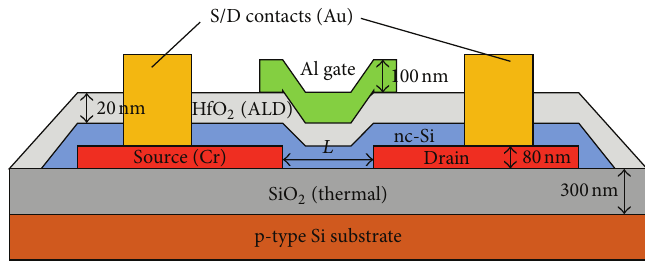
Figure 1: Schematic cross-section of a staggered top-gated nc-Si TFT.